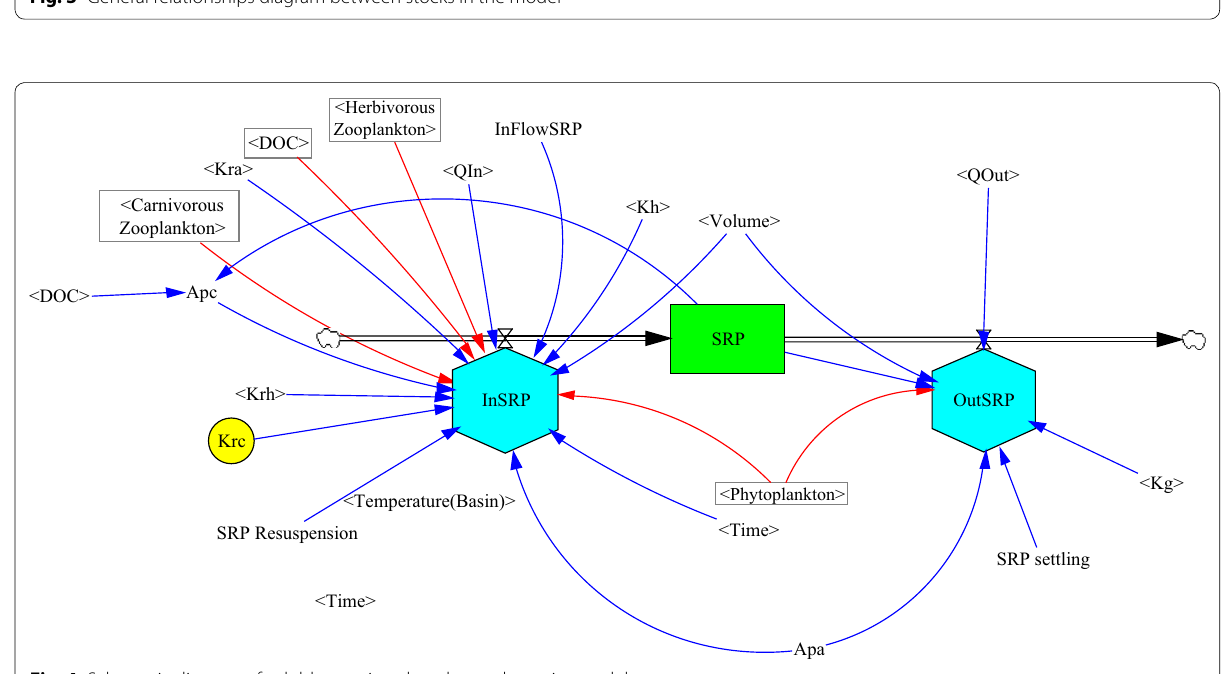
Fig. 4 Schematic diagram of soluble reactive phosphorus dynamics